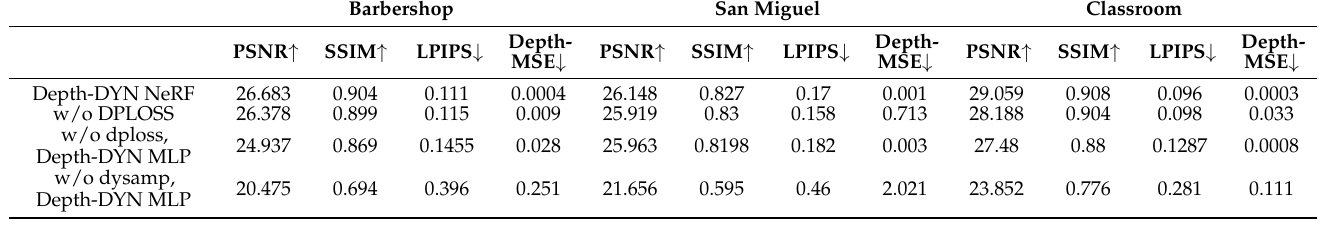
Table 2. Ablation studies performed on our model. The table shows a quantitative comparison of Depth-DYN NeRF without depth loss (w/o DPLOSS), without depth loss and depth MLP (w/o dploss, Depth-DYN MLP), and without dynamic depth and depth MLP (w/o dysamp, Depth-